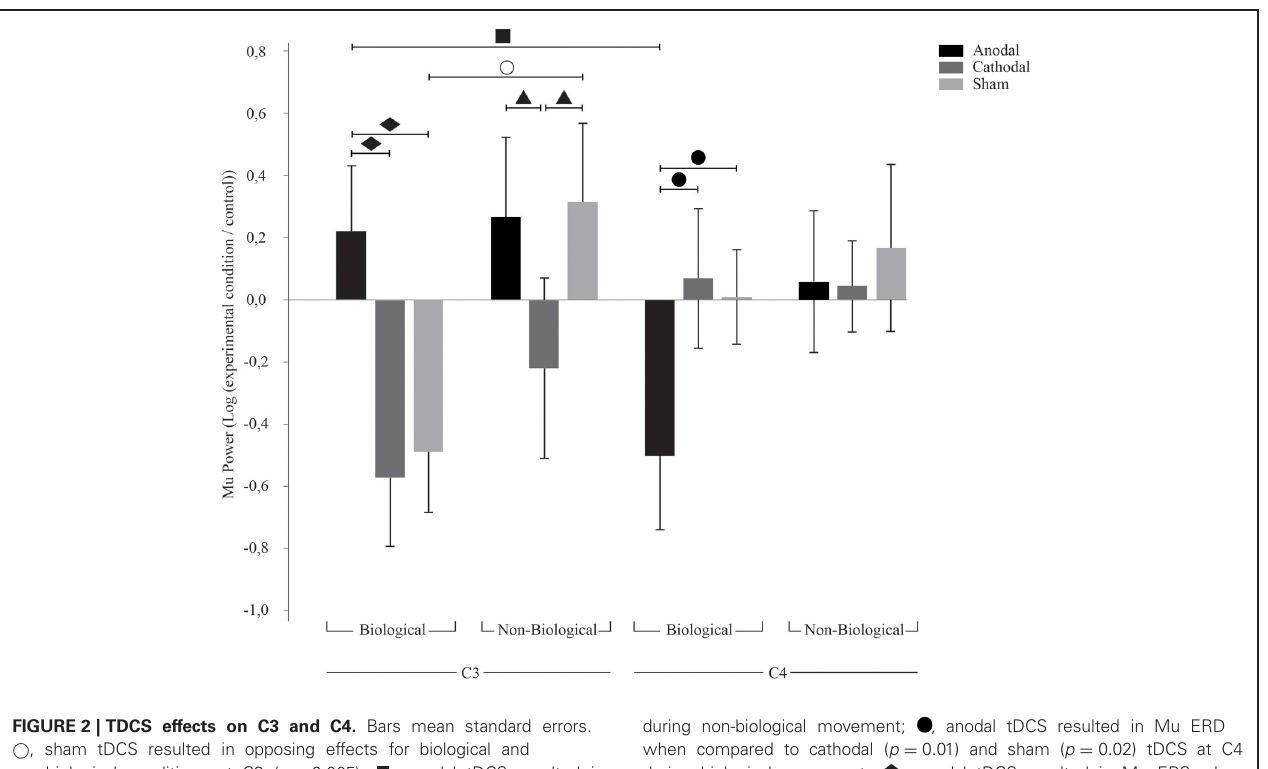
FIGURE 2 | TDCS effects on C3 and C4. Bars mean standard errors. during non-biological movement; , anodal tDCS resulted in Mu ERD (cid:3) , sham tDCS resulted in opposing effects for biological and when compared to cathodal ( p = 0 . 01) and sham ( p = 0 . 02) tDCS at C4 , anodal tDCS resulted in non-biological conditions at C3 ( p = 0 . 005); during biological movement; , anodal tDCS resulted in Mu ERS when (cid:0) ERS at C3 and ERD at C4 ( p = 0 . 01); , cathodal tDCS resulted in Mu compared to cathodal ( p = 0 . 001) and sham ( p = 0 . 002) tDCS at C3 ERD compared to anodal ( p = 0 . 03) and sham ( p = 0 . 02) tDCS at C3 during biological